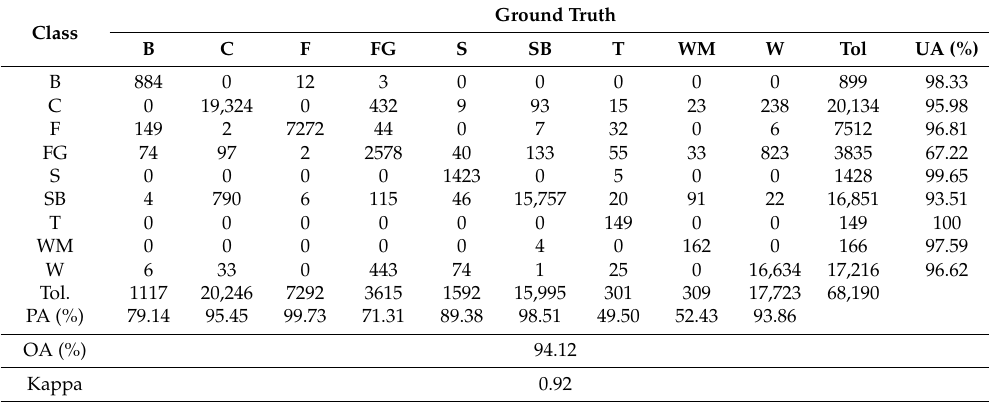
Table 5. The confusion matrix for the land cover mapping obtained using ND-RF method using all 11 RADARSAT-2 images (B, built-up; C, corn; F, forest; FG, forage; S, soil; SB, soybean; T, tobacco; WM, watermelon; W, wheat).